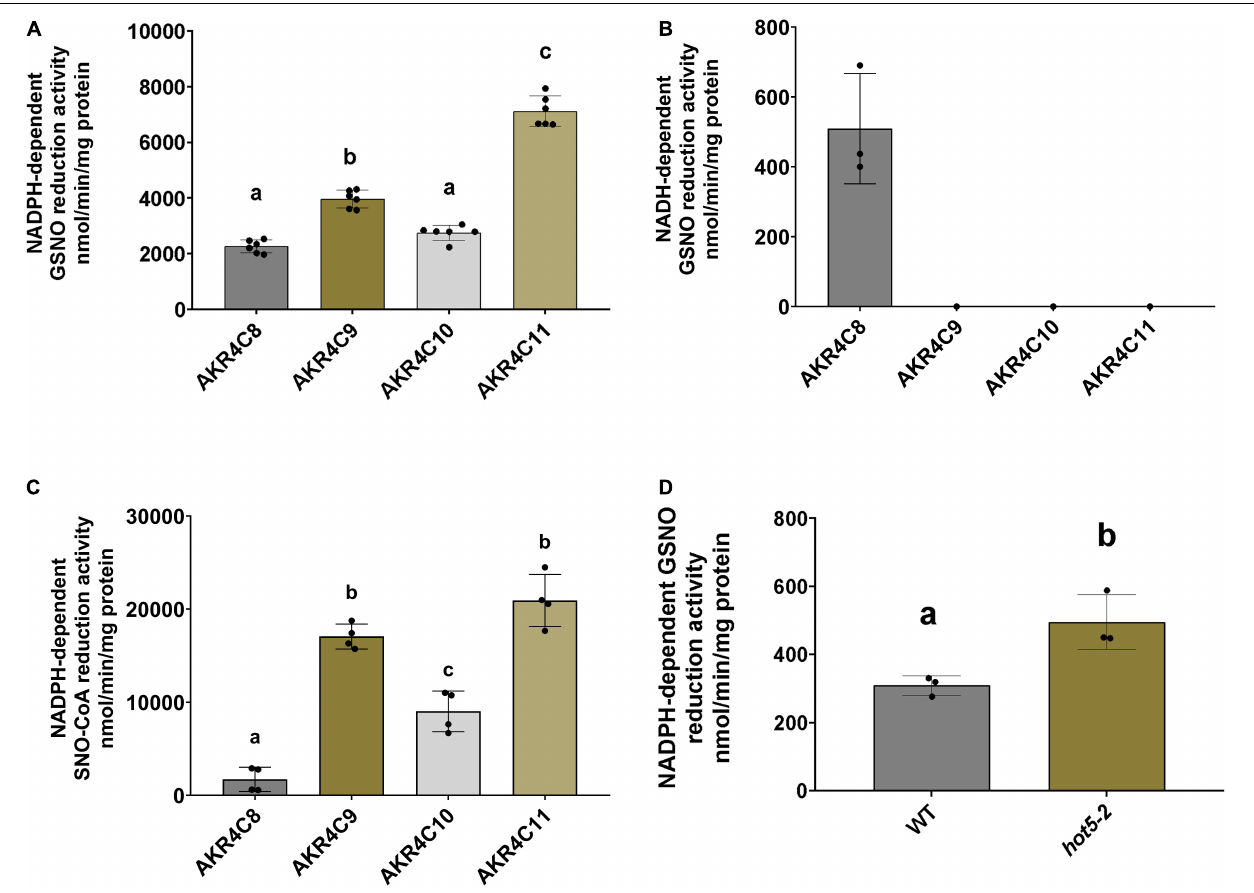
FIGURE 5 | AKR4Cs from A. thaliana exhibit GSNO reductase activity and NADPH GSNO reductase activity is increased in hot5-2 plants. Determination of NADPH- (A) and NADH-dependent (B) GSNO degradation activity by purified AKR4C proteins, respectively. (C) SNO-CoA reduction by AKR4C proteins using NADPH to provide reducing equivalents. Enzyme assays were performed at least in triplicate using two independent protein preparations. The bars represent means ± SD. For panels (A,C) different letters indicate groups of significant differences at p ≤ 0.05 calculated by one-way ANOVA with post hoc Tukey HSD. (D) NADPH-dependent in planta GSNO reduction activity of leaf extracts from 4- to 6-week-old WT and hot5-2 plants. Data represent the mean ± SD from three independent experiments. Different letters indicate significant differences of p ≤ 0.05 calculated by unpaired T